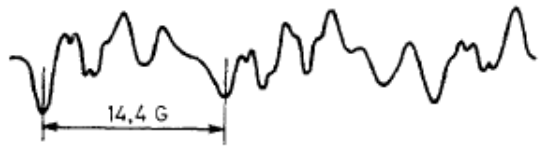
Figure 12. An EPR spectrum of SNR 323 .